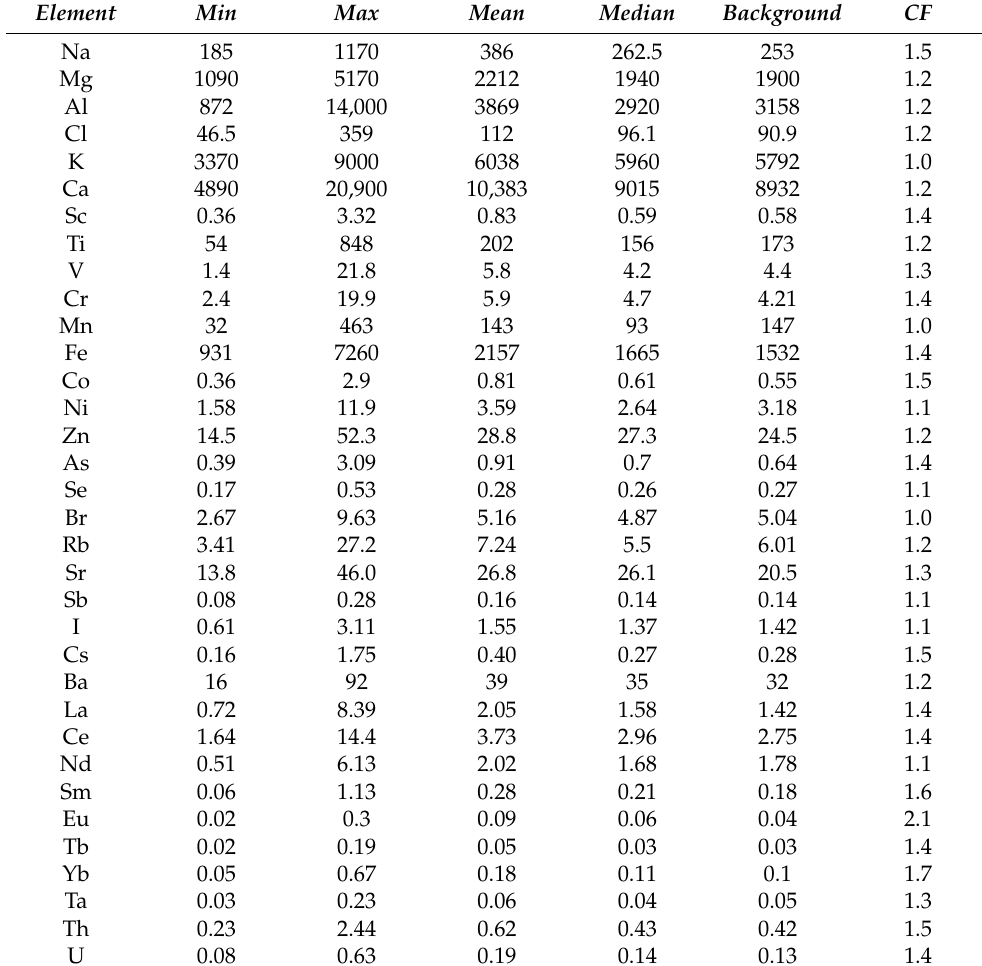
Table 2. Mass fractions of elements in samples (mg/kg) and contamination factors